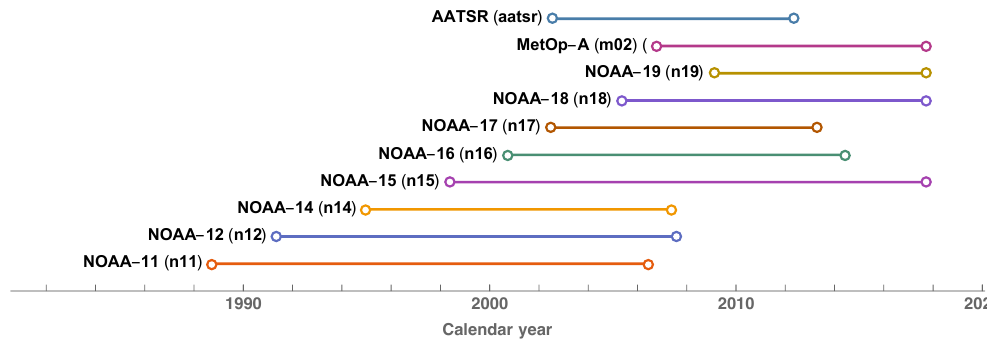
Figure 1. Timeline of NOAA and MetOp satellites, which have all been equipped with similar sensors, like, e.g., the AVHRR. The AATSR sensor onboard the Envisat satellite was similar to the